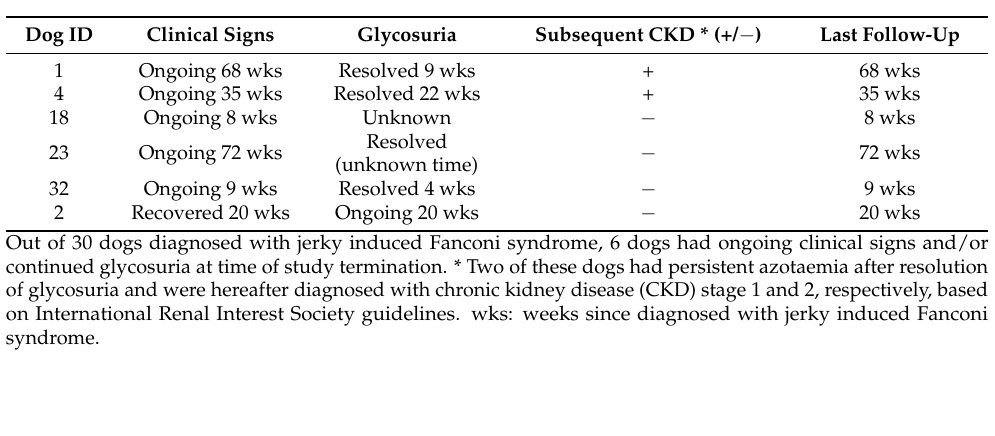
Figure 5. Clinical and para-clinical outcome of 30 dogs diagnosed with jerky induced Fanconi syndrome. Outcome of 30 dogs diagnosed with acquired Fanconi syndrome associated with ingestion of jerky treats. Dark color represents the number of dogs reported positive for the finding in question. The total height of each bar represents the total number of dogs for which the specific statement is relevant. The white numbers provide the percentage of positive findings. * Out of the 5 dogs reported to have continued clinical signs, 2 were diagnosed with chronic kidney disease (CKD) based on International Renal Interest Society guidelines. Table 2. Dogs still showing clinical signs or continued glycosuria at time of study